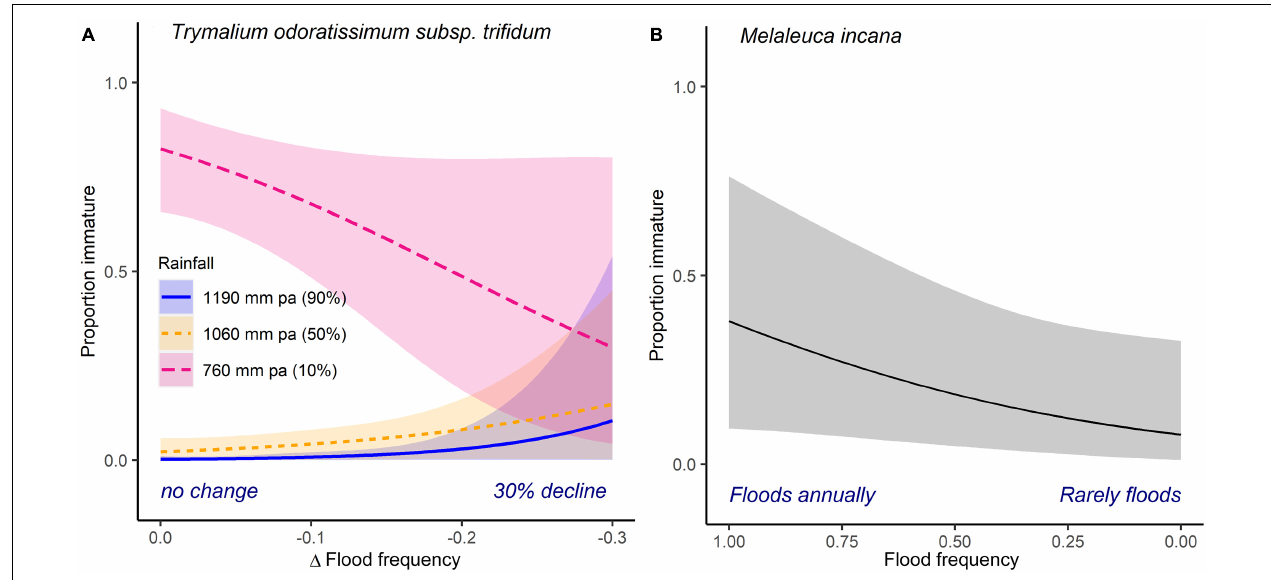
FIGURE 5 | Variation in the relative frequency of immature to mature individuals of upland tree (A) Trymalium odoratissimum subsp. trifidum and shrub (B) Melaleuca incana modeled as a function their hydrological conditions. Flood frequency and rainfall are as described in Figure 3 . The fitted line ( ± 95% confidence intervals) represents model predictions from binomial generalized linear mixed effects models.